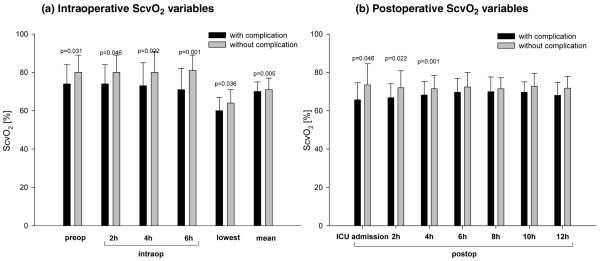
Intraoperative (a) and postoperative (b) ScvO2 variables in patients who did and did not develop postoperative complications. P values correspond to univariate analysis of variance. ICU, intensive care unit; IMC, intermediate care unit; intraop, intraoperative; preop, preoperative; postop, postoperative; ScvO2, central venous oxygen saturation.